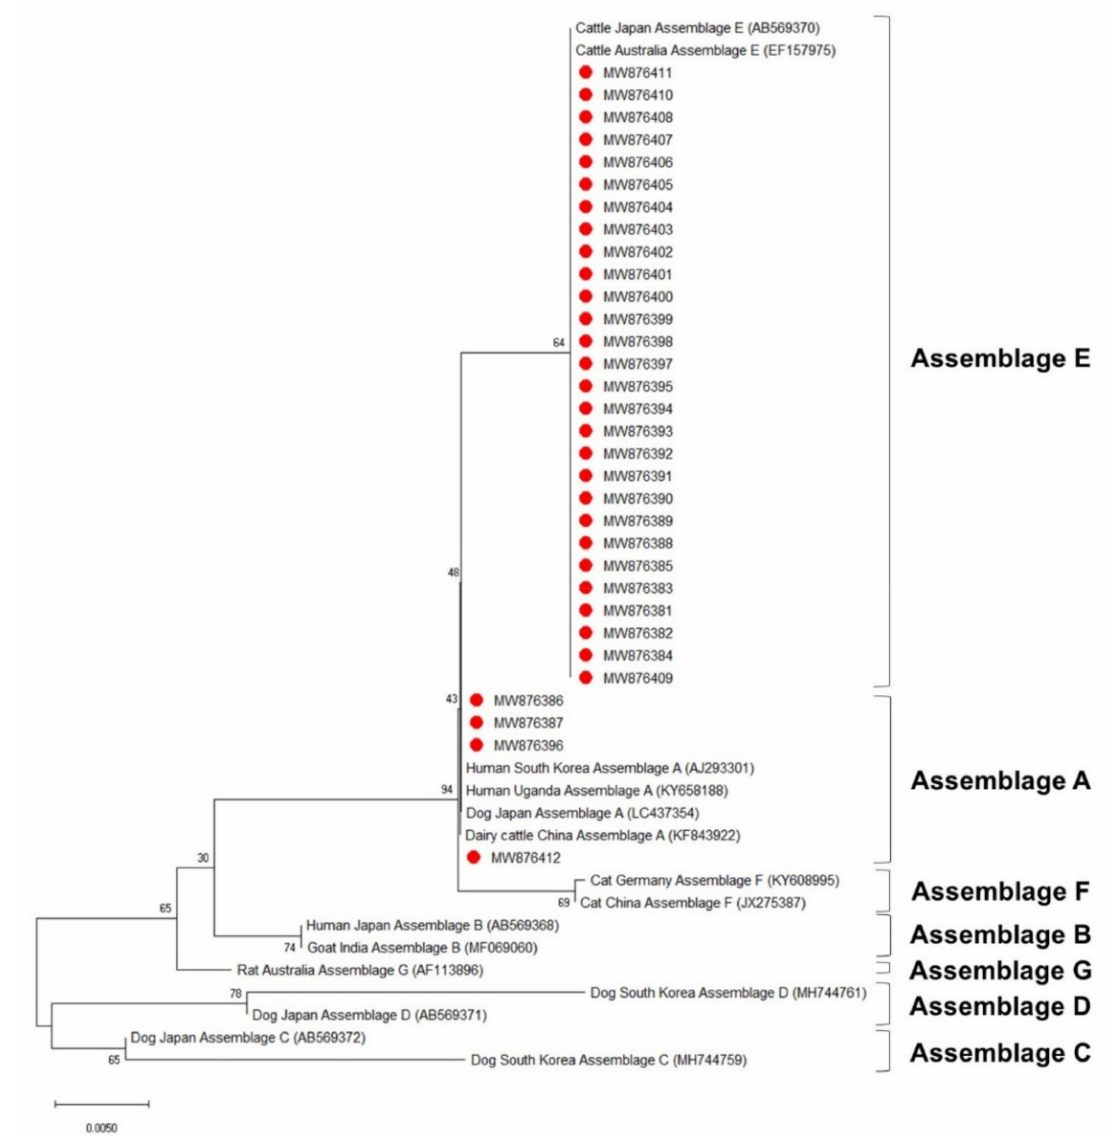
Figure 3. Phylogenetic tree of G. duodenalis based on SSU rRNA gene sequences. The neighbor-joining method was used to construct the tree; the red circles indicate the sequences detected in this study. The GenBank accession numbers are shown in parentheses, and the G. duodenalis assemblages are indicated with one-sided square brackets. Tree reliability was tested by running 1000 bootstrap